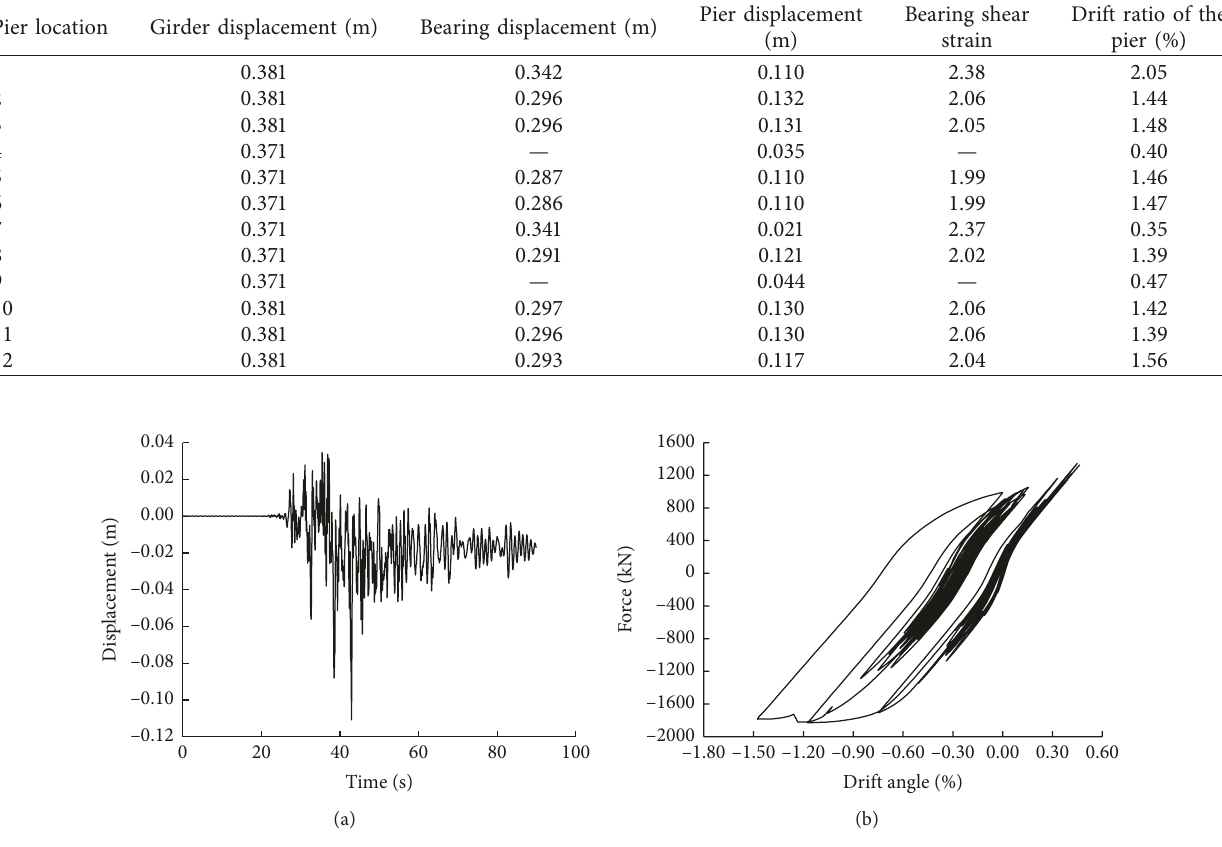
Figure 9: Response of the no. 12 pier. (a) Displacement response. (b) Force-displacement drifts